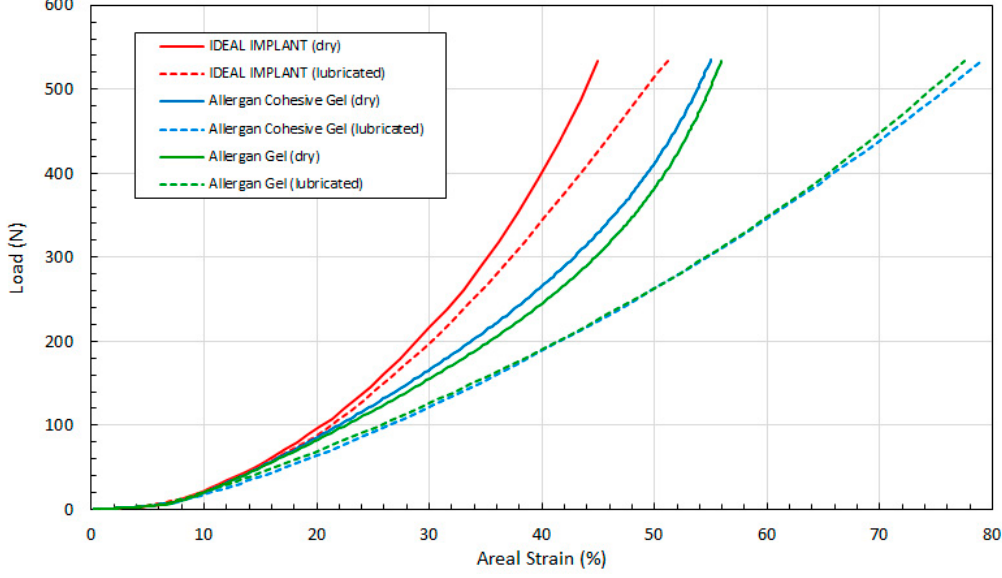
Figure 13. Load vs. Areal Strain, Dry and Lubricated Platens.